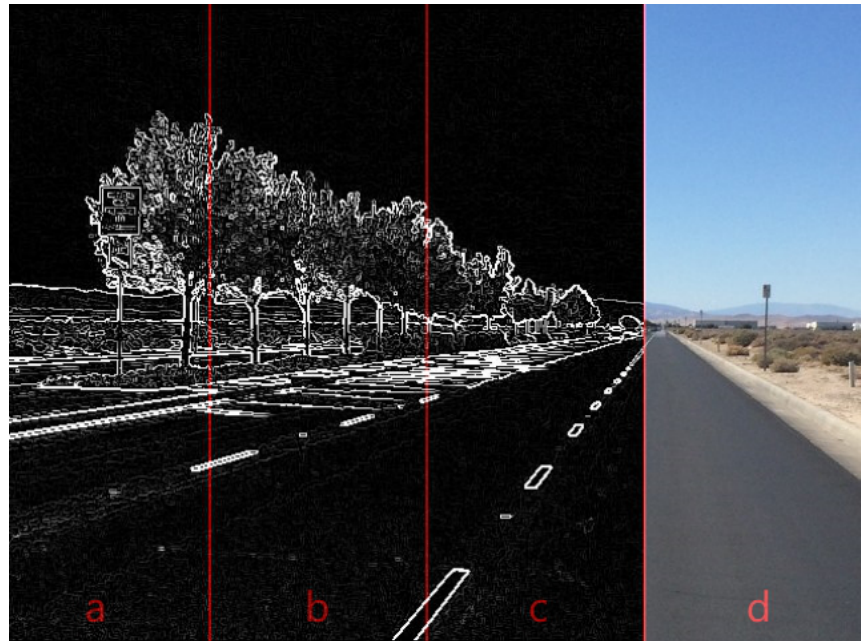
Figure 7. Combined results from all the platforms: ( a ) the result of the Pynq-Z1 implementation; ( b ) the result of DE2-115 implementation; ( c ) the result of a C++ algorithm running on a traditional CPU; and ( d ) the original